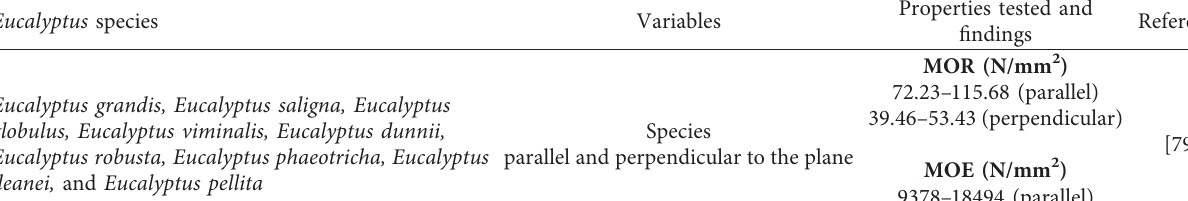
Table 1: Studies on Eucalyptus plywood